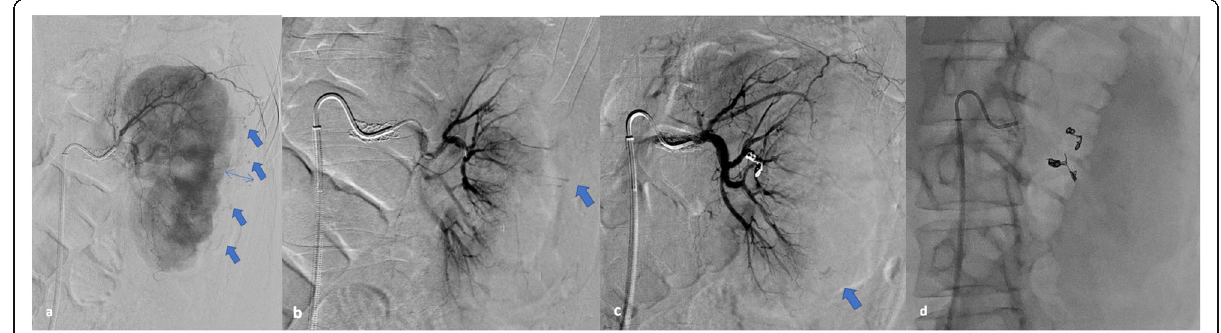
Fig. 3 a Final DSA demonstrating multiple foci of active extravasation at the upper, middle, and lower pole of the kidney (arrowhead) with corresponding large subcapsular hematoma (double arrow). b Selective DSA following the first coil embolization of one renal artery branch depicted a remaining site of active bleeding at the point of guide-wire distal migration (arrow). c Note that all other foci of extravasation are not depicted anymore. d Fluoroscopic image following second coil embolization of the more caudal renal artery